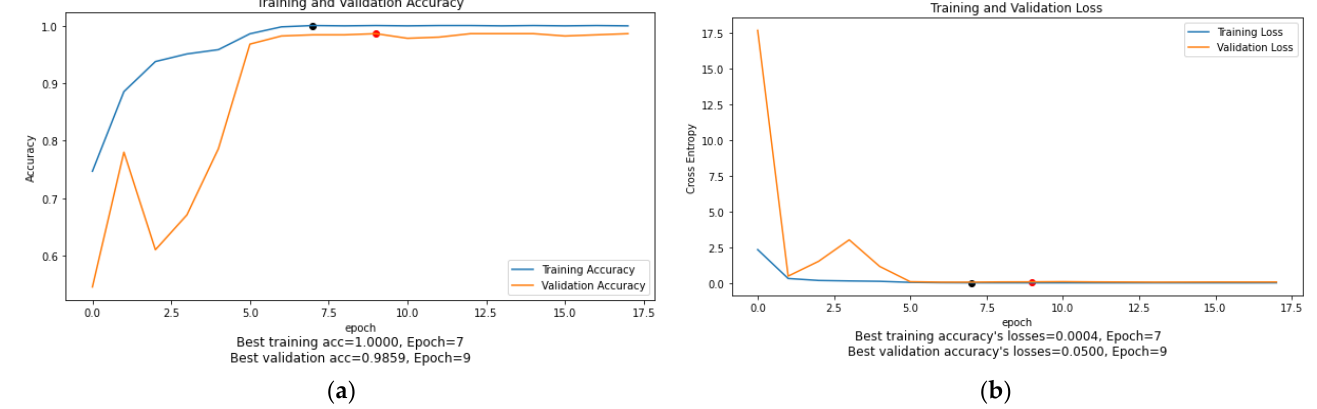
Figure 11. ( a ) Accuracy and ( b ) loss plots throughout the training process of the MobileNet model using the GRAY+GRAY_HE+GRAY_CLAHE image representation.